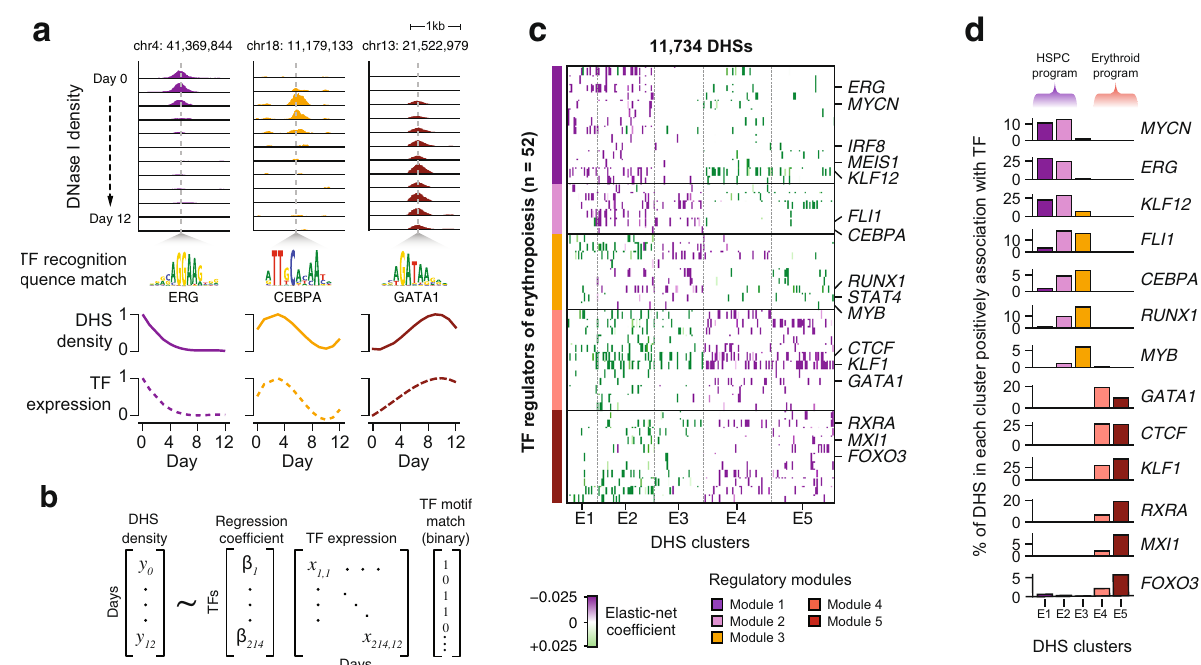
Fig. 3 Systematic modeling of cis - and trans - element temporal interactions reveals discrete regulatory modules spanning erythropoiesis. a Developmental responses of DHS accessibility and transcription factor expression levels were found to be correlated across the genome. b The density of a given developmental DHS is modeled after the TF binding motif composition and the expression of the binding TFs using elastic-net regression. The model returns a coef fi cient for each pair of DHS and binding TF which denotes how strongly (positively or negatively) the TF expression is associated with the accessibility of the particular DHS. c Hierarchical clustering of 52 highly connected TFs based on the cosine distances of the regression coef fi cient from 11,734 DHS reveals 5 clusters of developmentally regulated TFs. Transcription factors along with their positively associated DHS comprise a regulatory module (modules 1 – 5). d The fraction of DHS per cluster positively associated with a TF identi fi es the major drivers of chromatin accessibility during